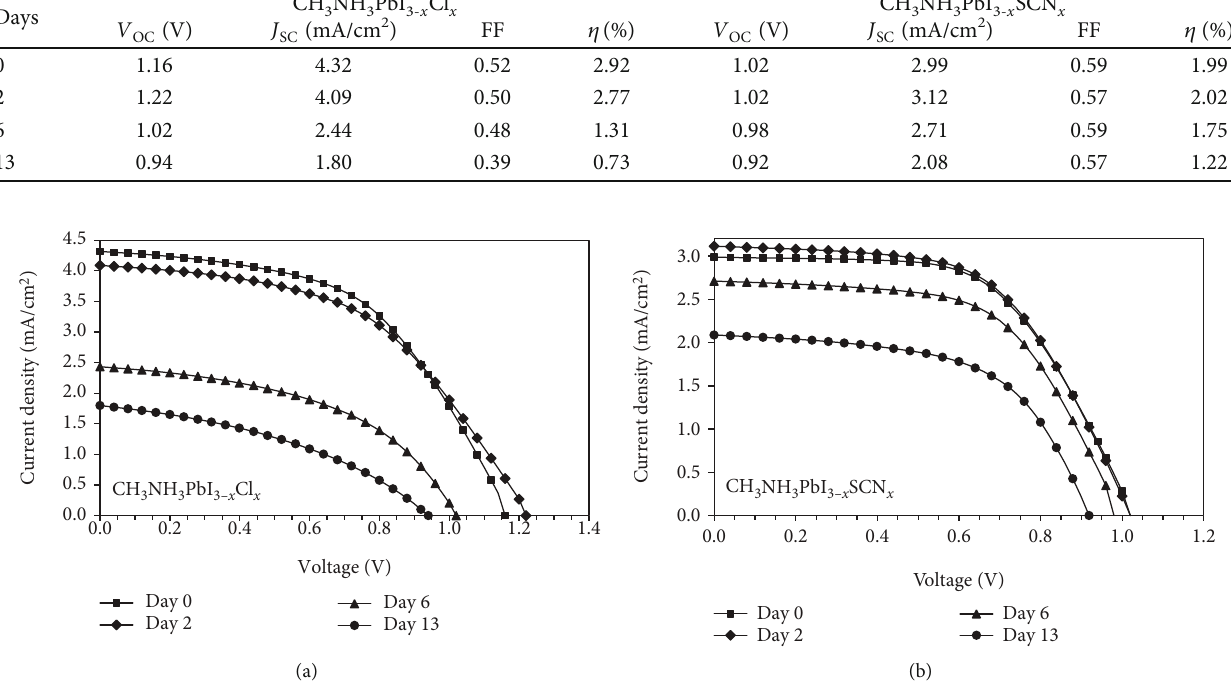
Figure 6: Current-voltage (I-V) characteristics of perovskite solar cell using (a) CH changes of I-V curve shape and decreasing short-circuit current and open-circuit voltage for 13 days.